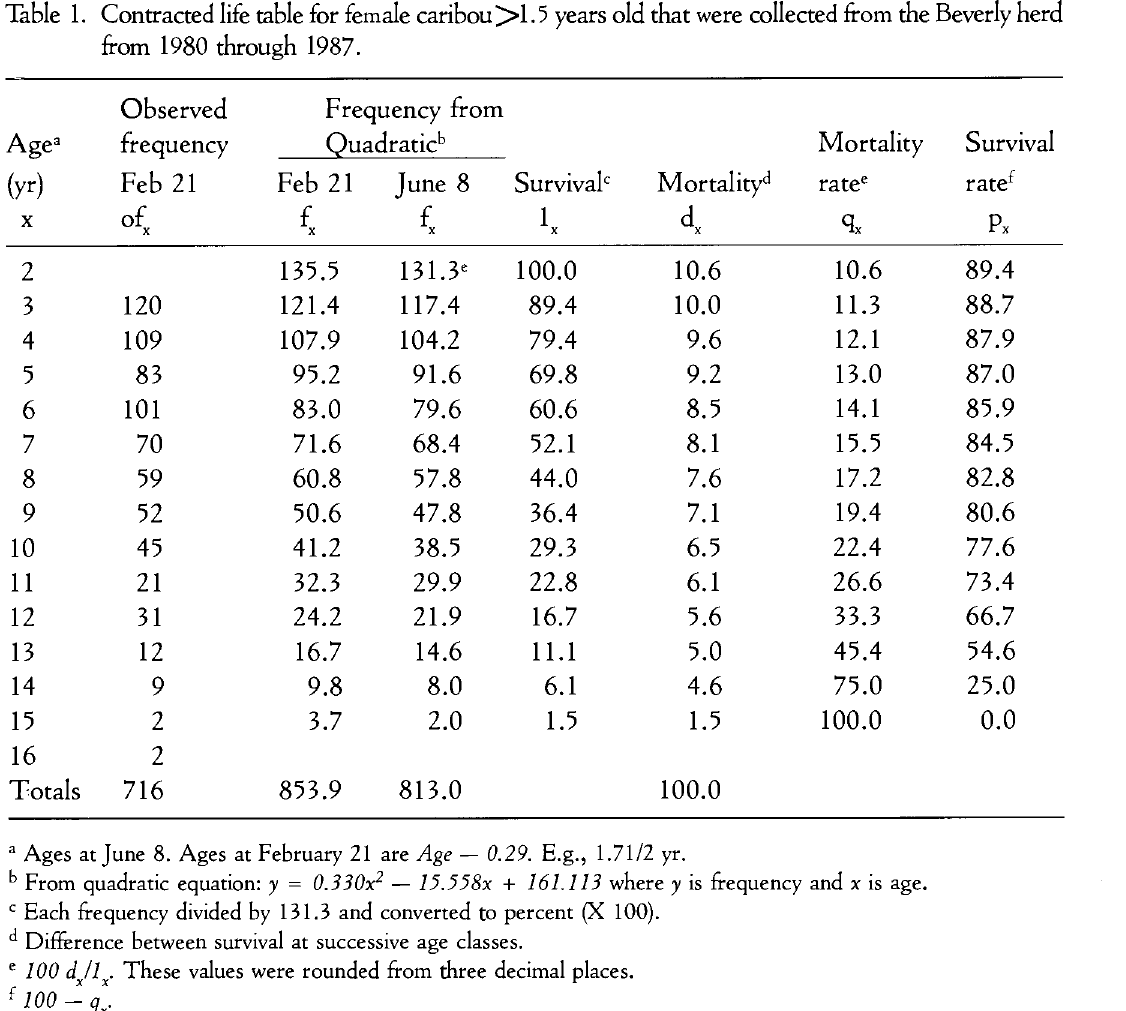
Table 1. Contracted life table for female caribou ]>1.5 years old that were collected from the Beverly herd from 1980 through